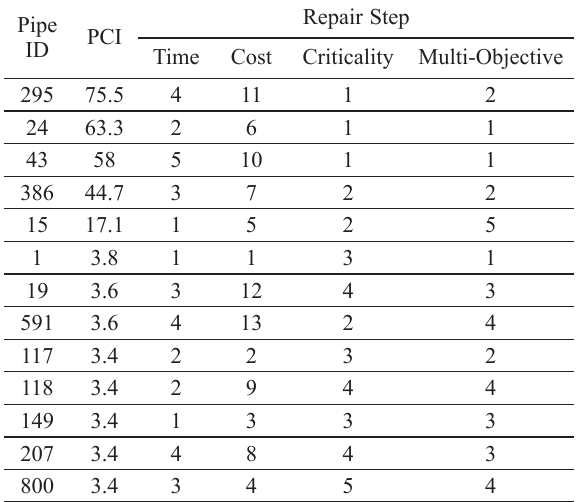
Table 4. Crew allocation results